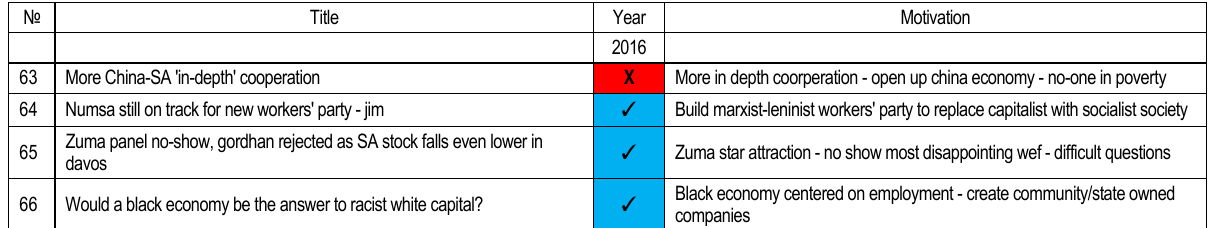
Table 2 (cont.). Movement towards socialism/communism of BEE (January 2014-January 2016)